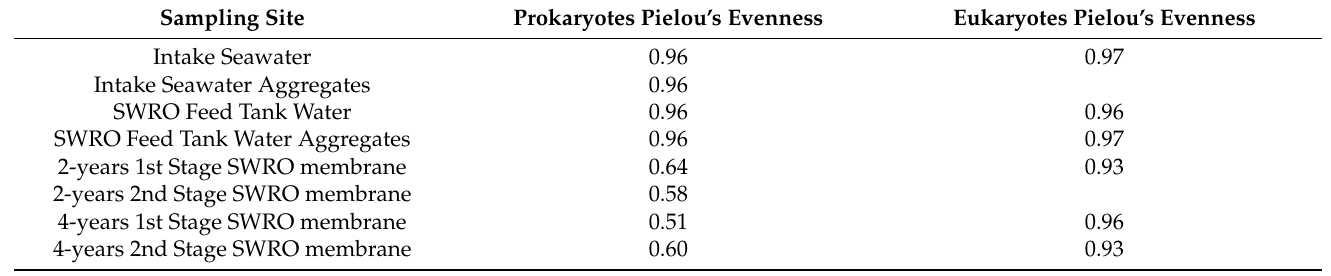
Table 1. Pielou’s evenness values of the prokaryotic and eukaryotic organisms in the water, aggre- gates, and biofouled membranes analysed in the present study.